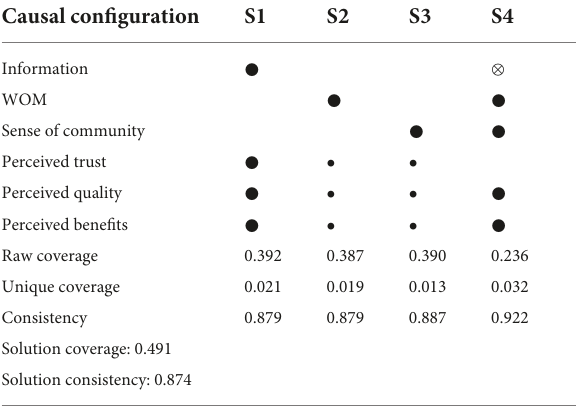
TABLE 4 Configurations for achieving high levels of the outcome conditions